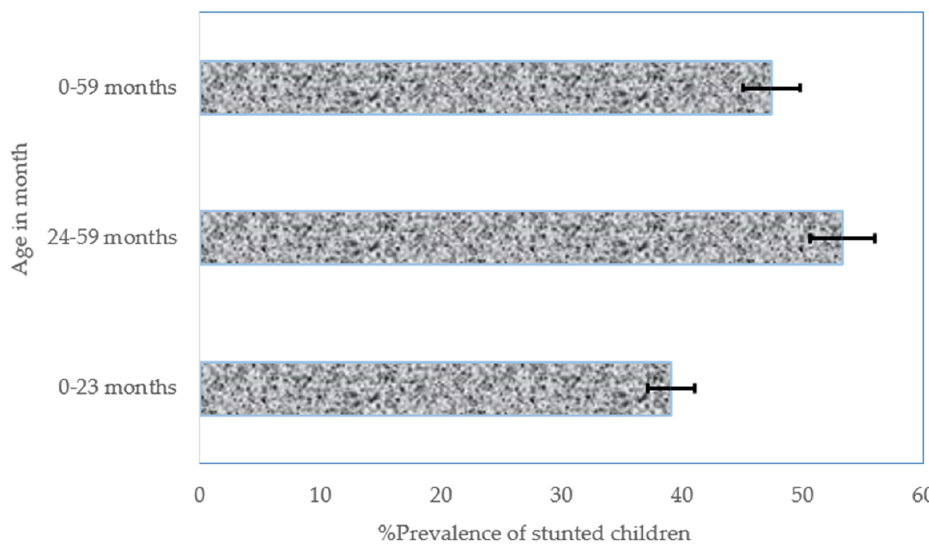
Figure 1. The overall prevalence of stunted children between 2008 and 2018 in the NGZs by age in months. Notes: If 95% confidence interval (CI) bars do not overlap, it implies that the difference is statistically significant ( p –value < 0.05).